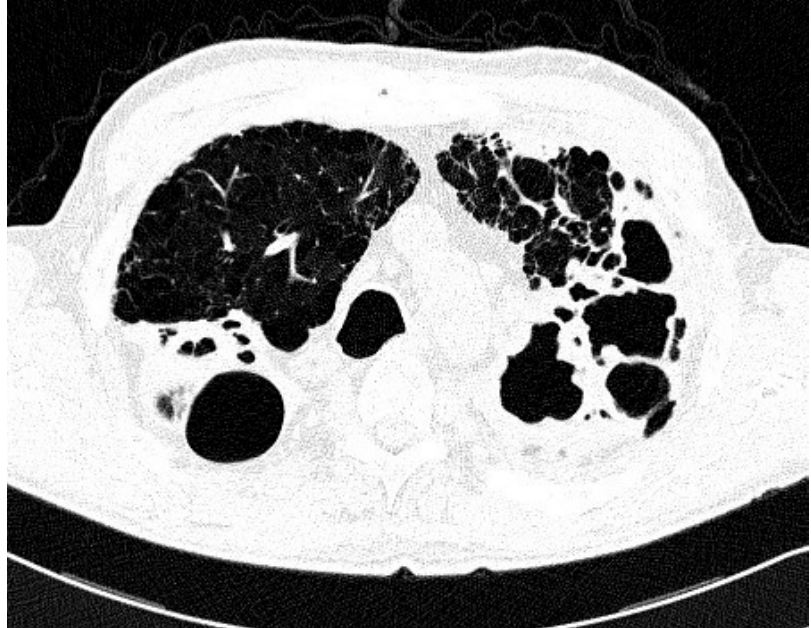
Figure 1. Trans-axial lung window CT scan in patient with non-tuberculous mycobacteria lung disease (NTM-LD) and chronic obstructive pulmonary disease (COPD) shows emphysema and multiple thick-walled cavities in both upper lobes.